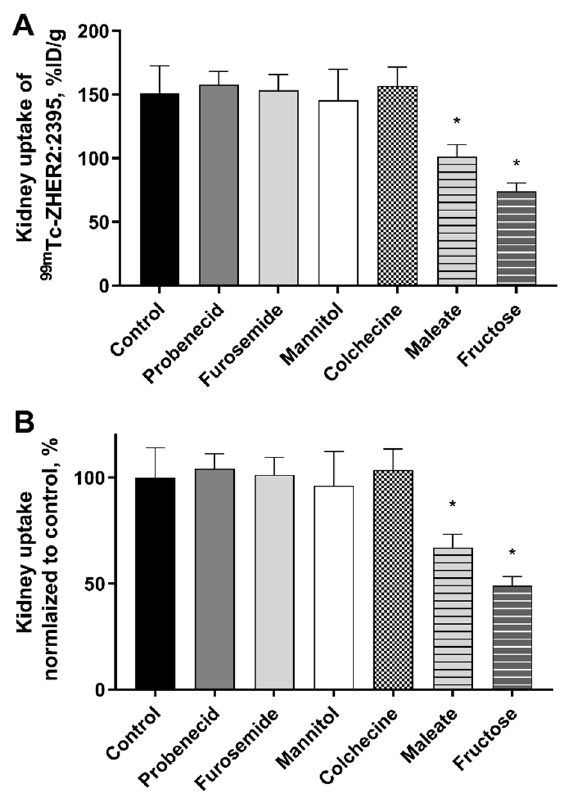
Figure 1. Kidney uptake of Z HER2:2395 affibody molecule labelled with 99m Tc in NMRI mice 4 h after injection. ( A ) The effect of various compounds on the kidney uptake of [ 99m Tc]Tc-Z HER:2395 represented as % ID/g. ( B ) The kidney uptake normalized to control in %. Data are expressed as an average of four animals ± SD. Asterisk (*) indicates a significant difference between control and the treated group (* p < 0.001, one-way ANOVA test).